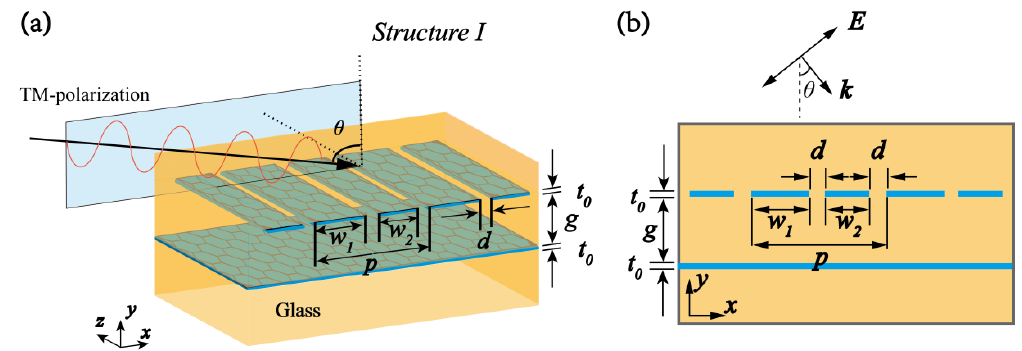
Figure 1. ( a ) First schematic of the proposed structure. The graphene nanoribbons (GNRs) are lying periodically above an infinite-width graphene sheet and p represents the cycle of the unit element. The distance between GNRs and the graphene sheet is g . The widths of the two adjacent GNRs are defined as w 1 and w 2 , respectively; ( b ) Cross-sectional diagram of Structure I.